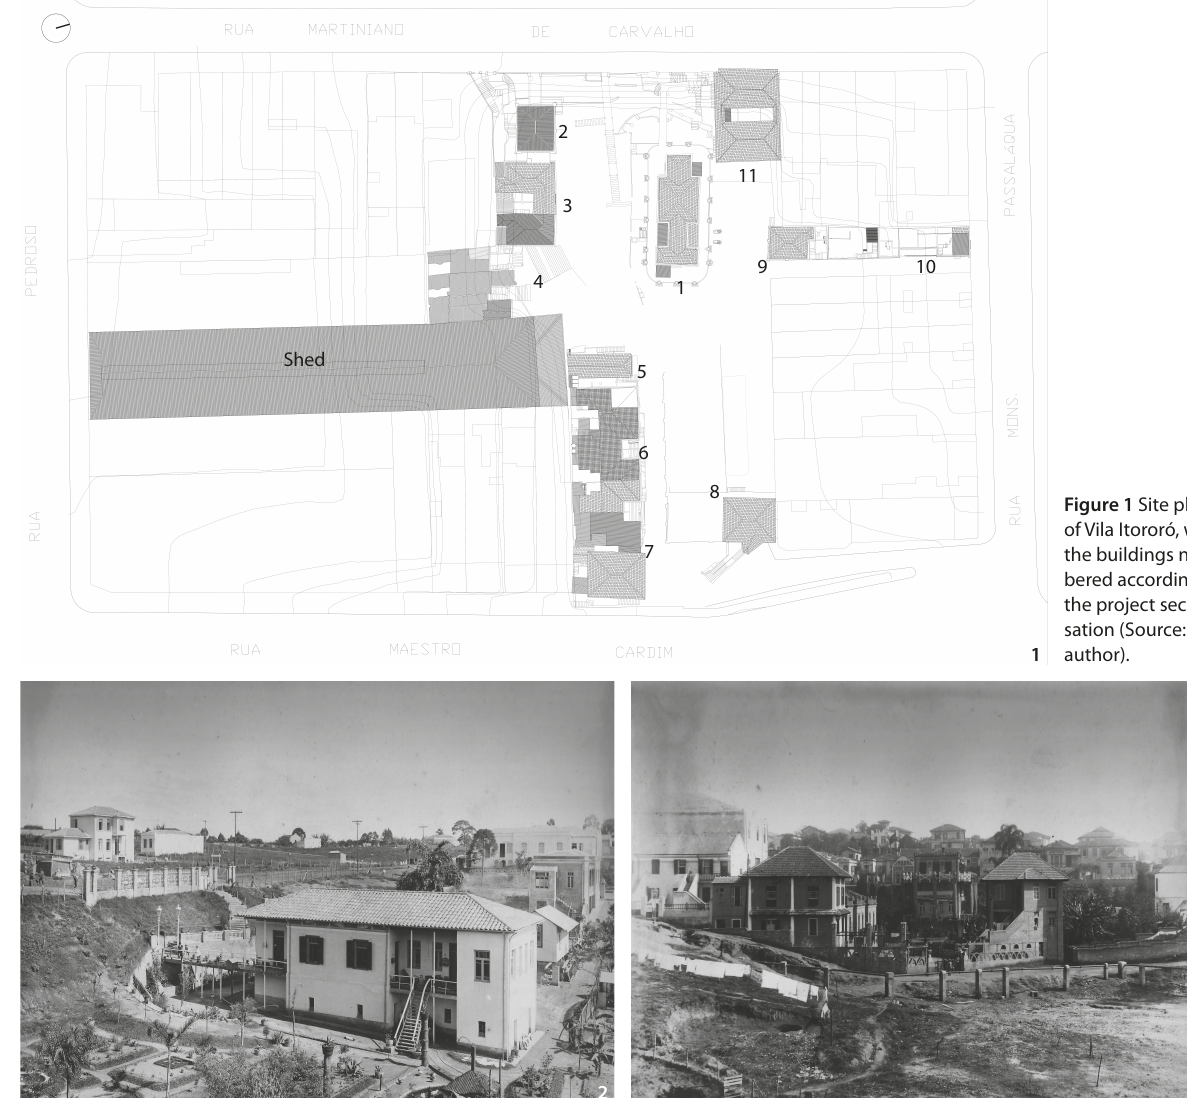
Figure 2 Vila Itororó situated below Martiniano de Carvalho Street. The house in the foreground would be altered by Francisco de Castro to later become the ‘Mansion’, between 1918 and 1922 (Source: Acervus of Milu Leite, c. 1914). Figure 3 Vila Itororó as seen from the valley. The ‘lower Vila’ would open itself to the valley (Source: Acervus of Milu Leite, date